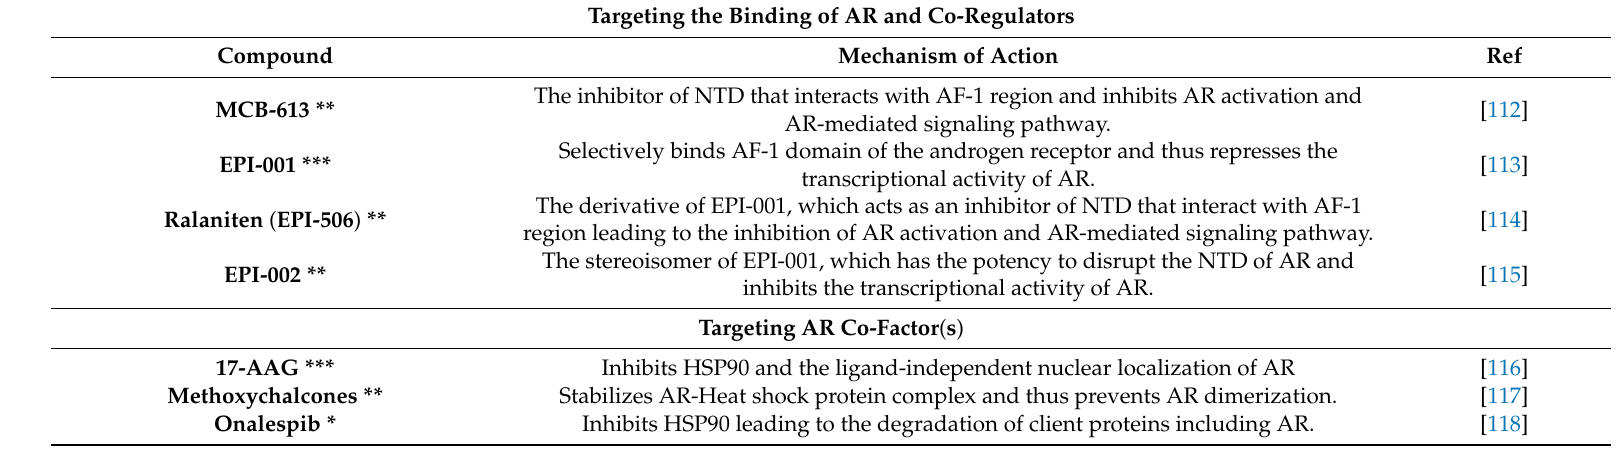
Table 3. List of compounds that interferes with the interaction of AR with co-regulators / co-factors, and their mechanisms of action (* compounds that are / were in clinical practice, ** compounds that show promise in preclinical studies, but have not yet been evaluated in clinical trials or have yet brought to clinical practice), *** compounds that showed promise in preclinical studies, but failed in clinical trial,